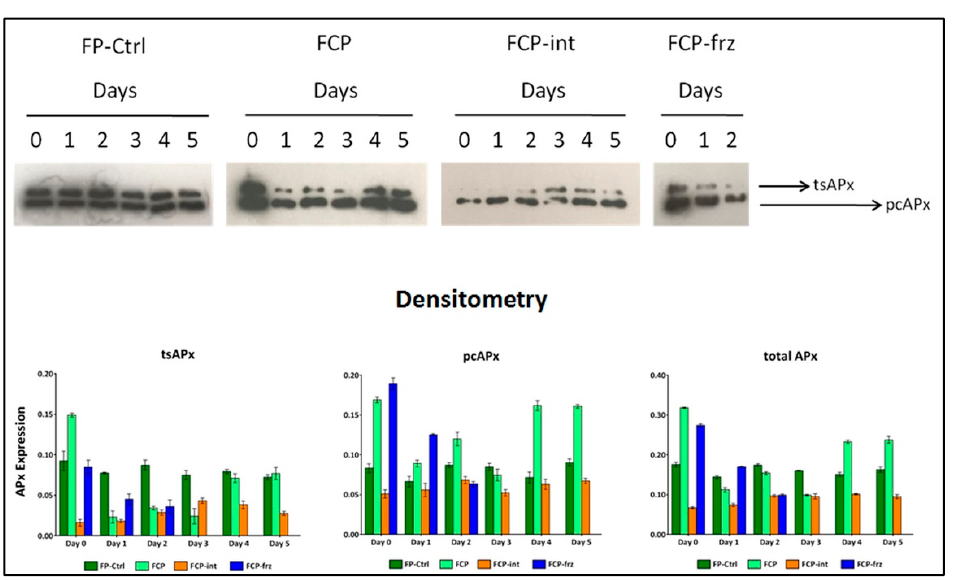
Figure 5. Changes in APx expression in fresh and fresh-cut parsley under different storage conditions, determined by Western blot analysis (cropped images), from three independent experiments and normalized with Ponceau (see Figure S6 in Supplementary Materials). The expression of thylakoid and stromal (tsAPx), peroxisome and cytosolic (pcAPx) isoforms, as well as the total APx, is shown in the graphs according to the optical density of APx protein. Values are means ± standard deviation, n = 3. Mean comparisons are reported in Table S2 in Supplementary Materials.